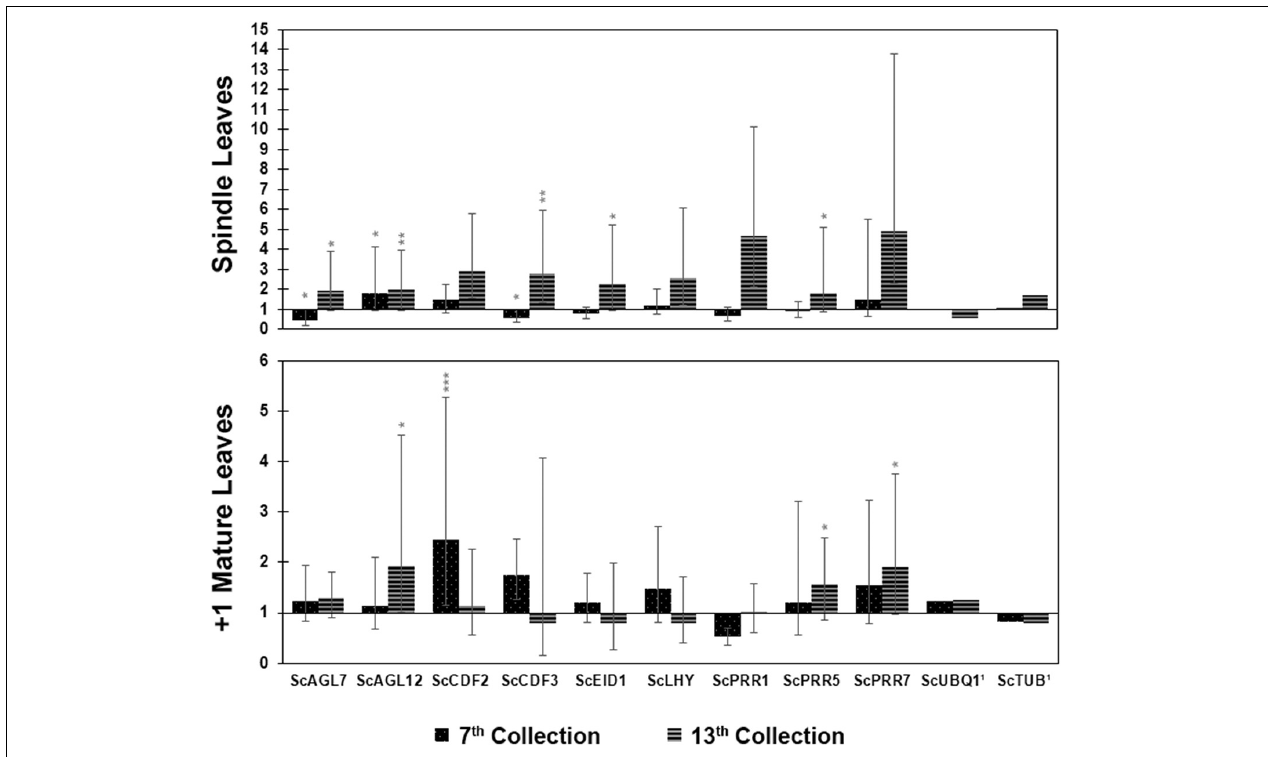
FIGURE 3 | Relative expression (induced/non-induced) of circadian clock genes at two time points following the start of the photoperiodic treatment; seventh week (45 days) and 13th week (85 days), from both spindle leaves and mature leaves. 1 Reference Genes. P < 0.001 (***); P < 0.01 (**); and P < 0.05